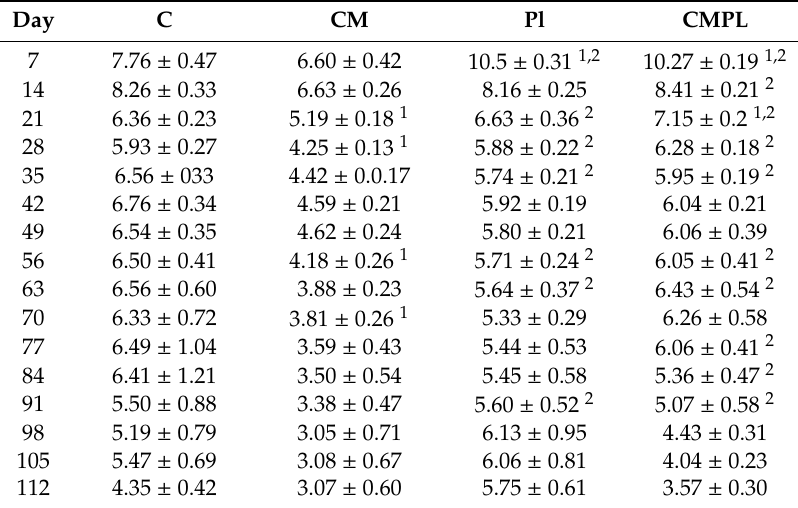
Table 1. The area of the total changed surface of animal skin in LRI (cm 2 ).